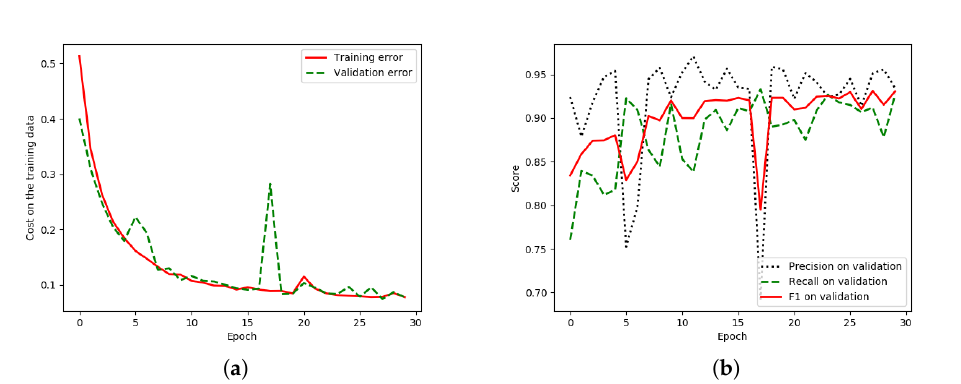
Figure 16. Graph (learning curves) on Landsat-8w5c data set of the proposed approach, “HR-GCN-FF-DA”; x refers to epochs, and y refers to different measures ( a ) Plot of model loss (cross-entropy) on training and validation corpora; ( b ) performance plot on the validation